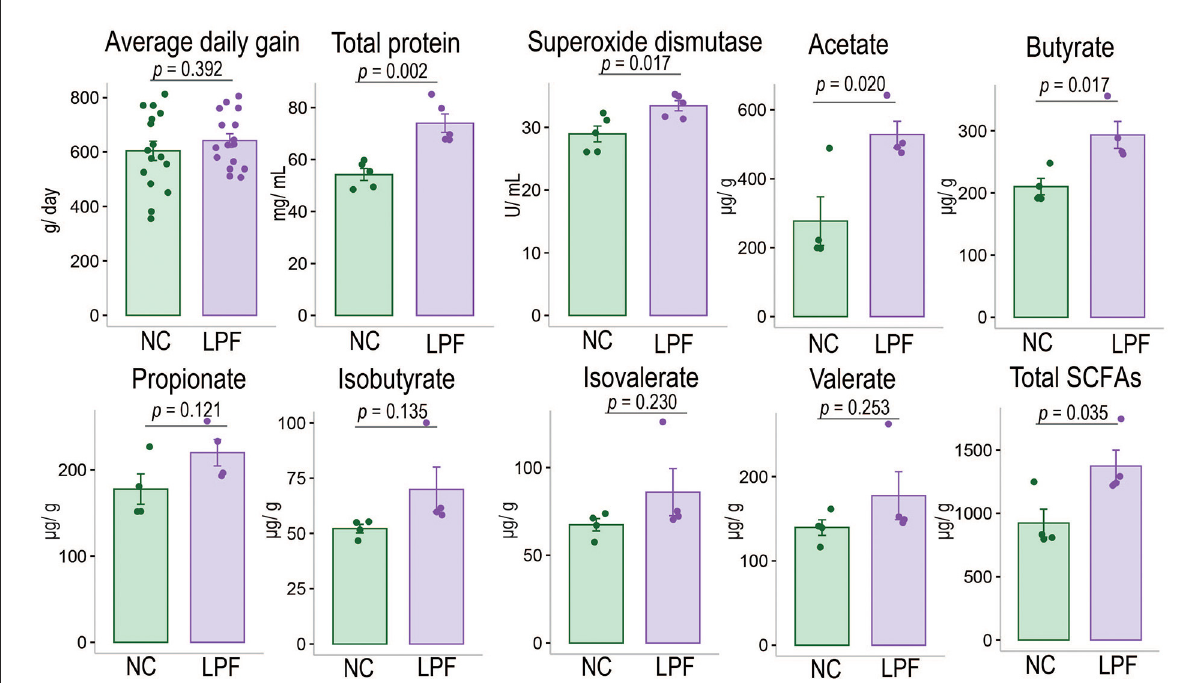
FIGURE1 Effects of LPF diet on average daily gain, serum indexes, and fecal SCFAs of nursery pigs compared with NC diet. NC diet: basal diet, LPF diet: NC + 10% Lactobacillus plantarum and Pediococcus acidilactici co-fermented feed.